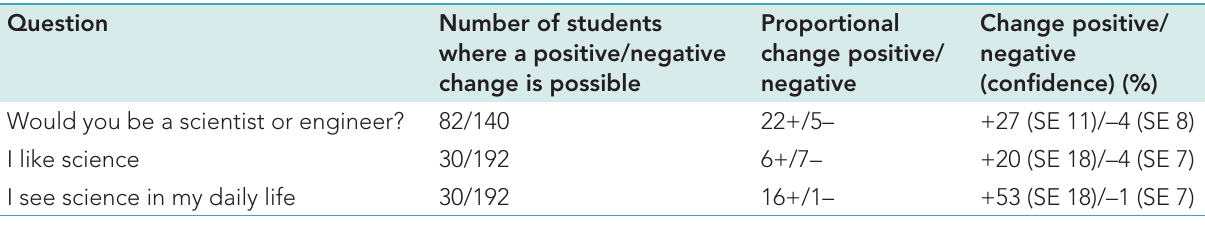
Proportional negative change positive/ where a positive/negative negative change is possible